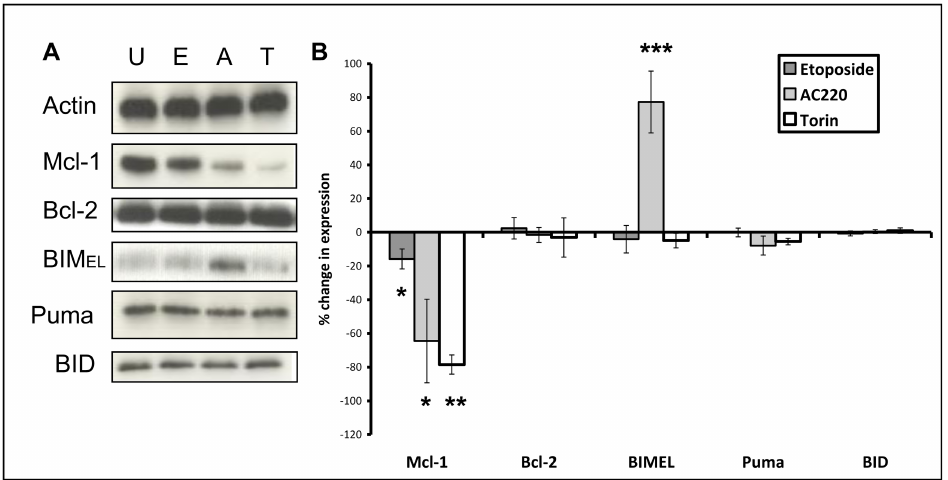
Fig 5. Changes in expression of apoptotic modulator proteins after four hours drug exposure. (A) MV4-11 cells were treated for four hours with 1 μ M etoposide (E), 10 nM AC220 (A) or 1 μ M torin1 (T). Each blot represents one of three independent experiments. (B) Blots were subjected to densitometry analysis using Image Studio Lite software (version 5.2). Values shown are percent change in expression normalised to loading control ( (cid:3) p = < 0.05/ (cid:3)(cid:3) p = 0.002/ (cid:3)(cid:3)(cid:3) p = 0.02), analyzed using paired samples t-test, +95% confidence interval. Columns, mean of three experiments; bars, SD.